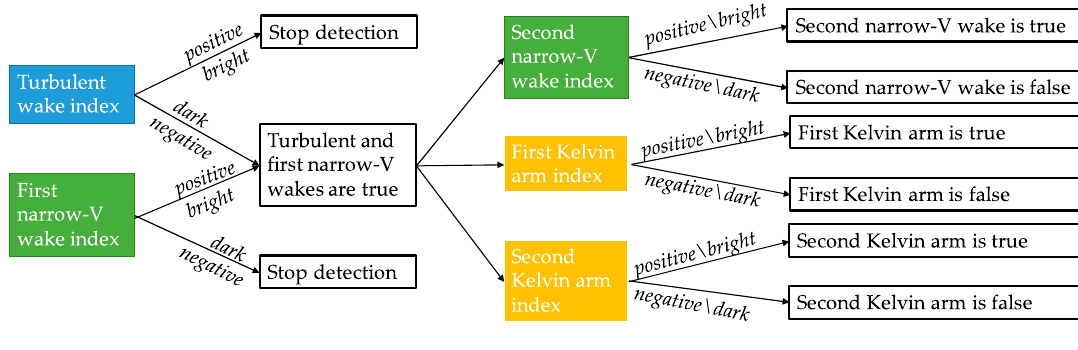
Figure 3. Wake classification criterion.